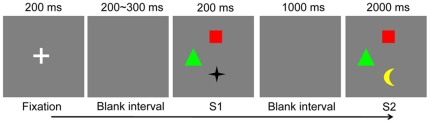
Illustration of a trial in Experiment 1, in which the black star is changed to a yellow moon.